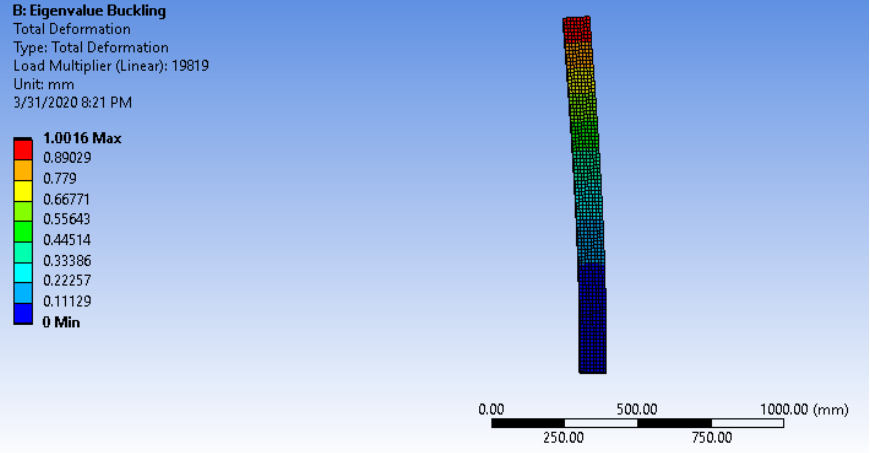
Figure 7. The second mode of buckling failure was gross-buckling along the strong axis.